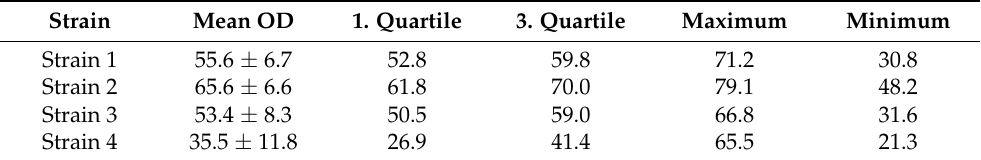
Table 2. Descriptive statistics of the final OD. The population mean, 1. and 3. Quartiles, maxi- mum and minimum were calculated for each strain. Strains 1 and 3 had similar growth behavior, whereas fermentations with strain 2 generally resulted in the highest and strain 4 in the least biomass accumulation. All values were calculated using the set of final OD values. Strain Mean OD 1. Quartile 3. Quartile Maximum Minimum Strain